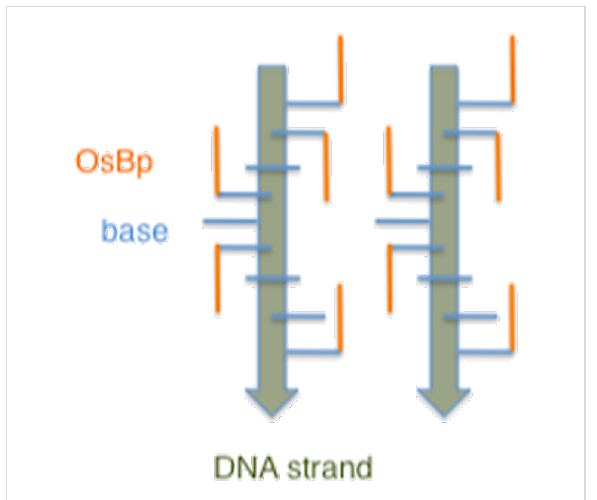
Figure 5: Representation of osmylated DNA strands to illustrate the practically parallel line-up of the OsBp moieties to the direction of the strand. This picture also demonstrates the plausible complexation of two strands by hydrophobic interactions between the OsBp moieties. Note that OsBp can add from the top or the bottom of the C5–C6 double bond, and vary from molecule to molecule (not shown here). Complexation is favored in solutions at relatively high oligo and high salt